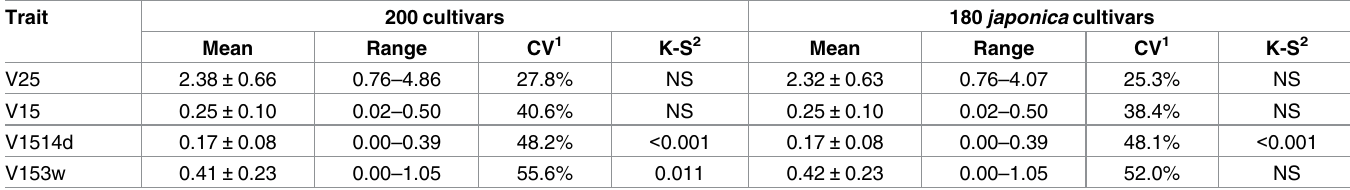
Table 1. Phenotypic variation for coleoptile growth rates (mm/d) during germination of rice seeds at 25˚ (V25) or 15˚C (V15, V1514d, V153w).